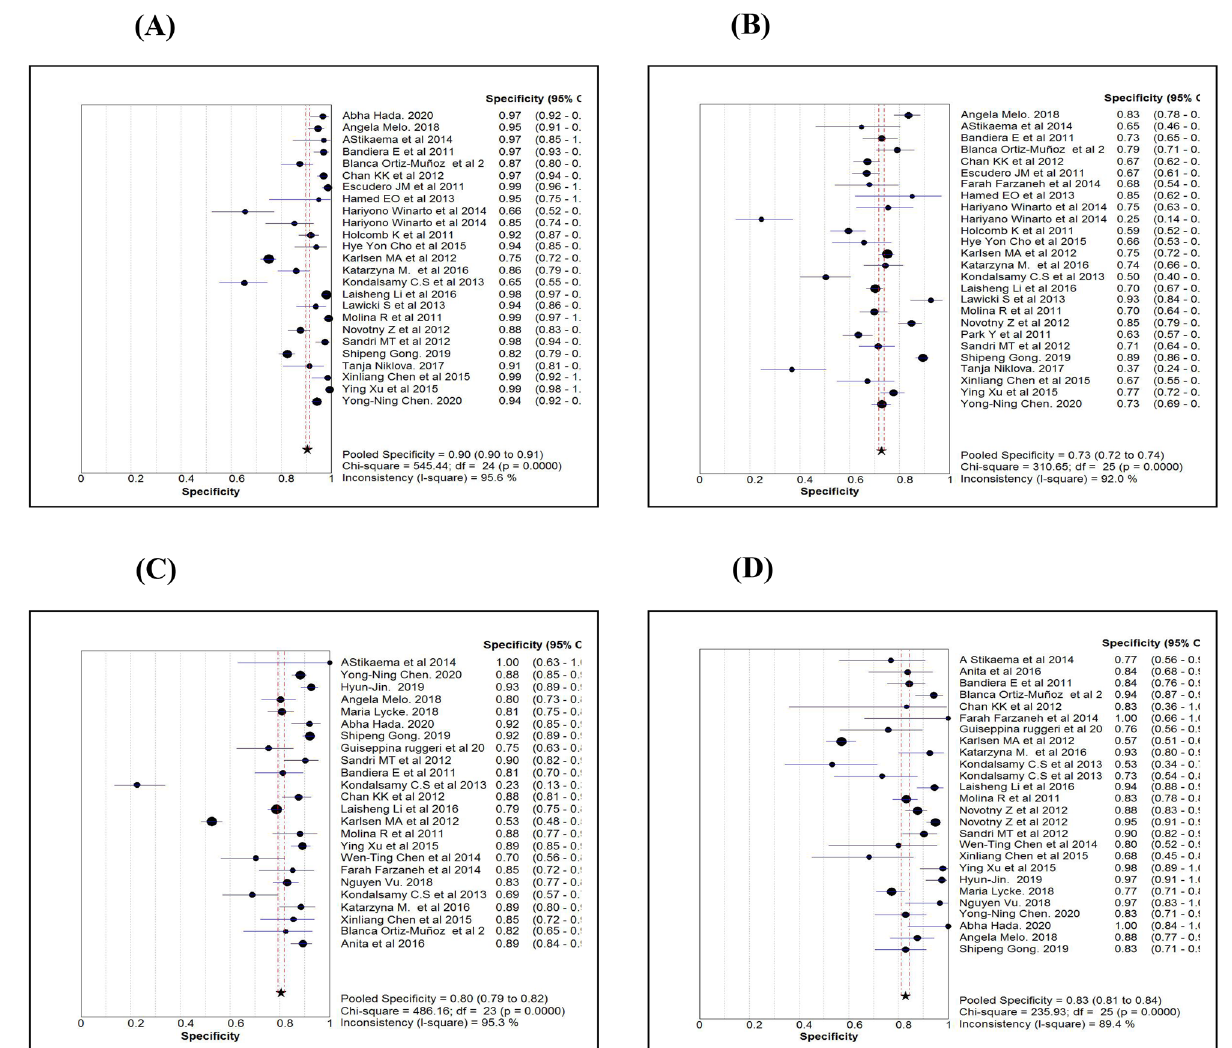
Figure 4. Comparison of Specificity estimates of HE4 ( A ), CA125 ( B ), ROMA for pre-menopause ( C ) and ROMA for post-menopause ( D